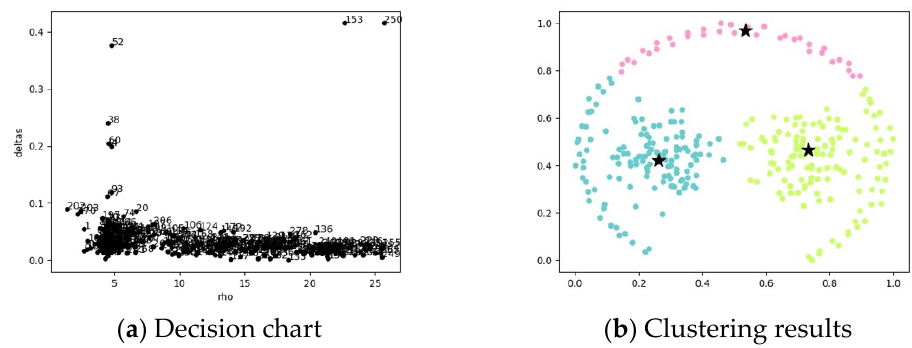
Figure 2. Decision graph and clustering results of DPC on the Pathbased dataset.